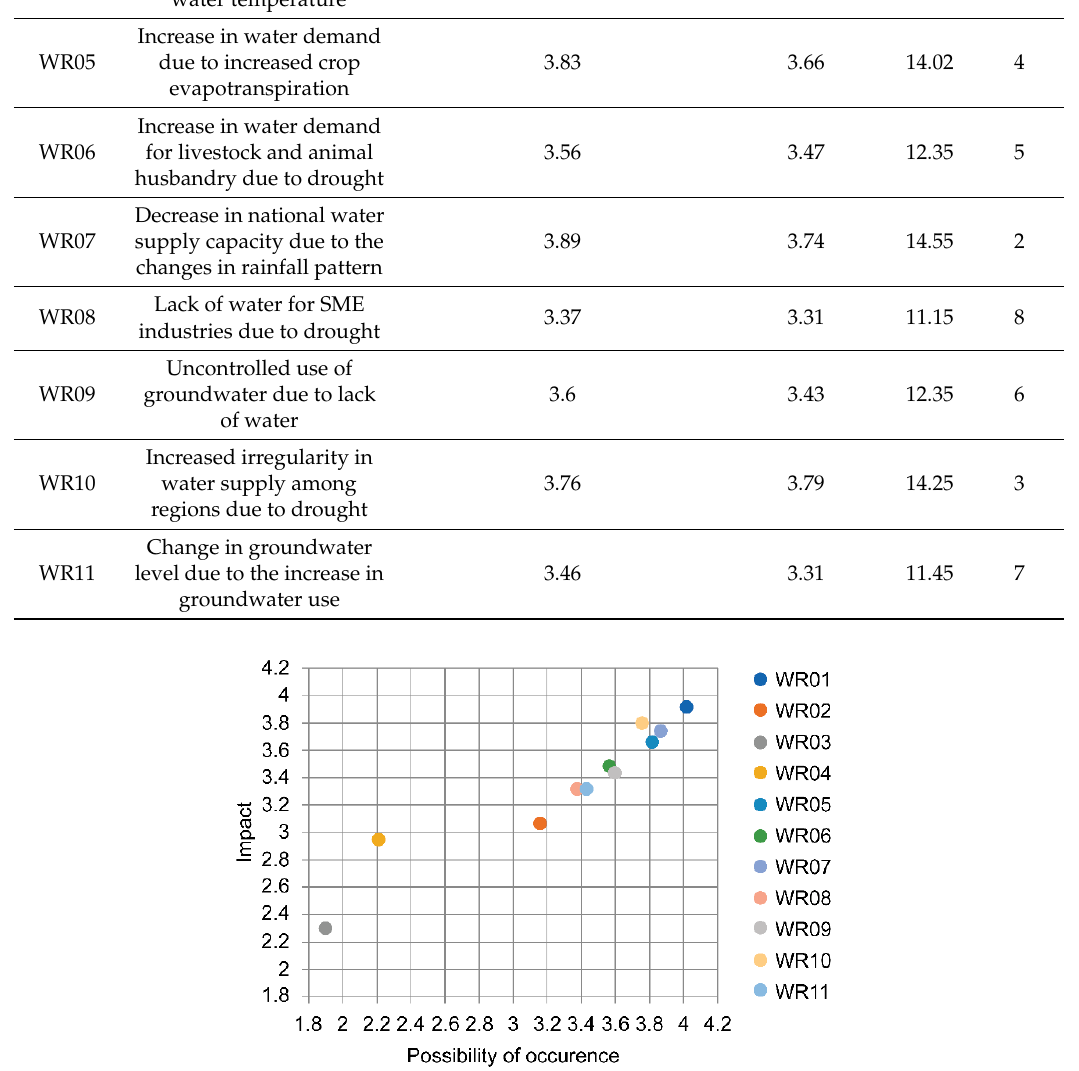
Table 5. Rank of WR (water resources risk/vulnerability) risk factors.